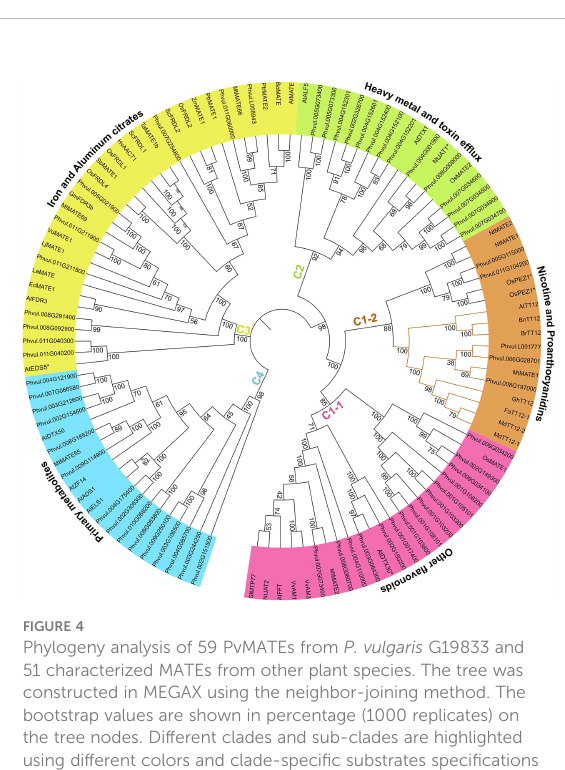
FIGURE 4 Phylogeny analysis of 59 PvMATEs from P. vulgaris G19833 and 51 characterized MATEs from other plant species. The tree was constructed in MEGAX using the neighbor-joining method. The bootstrap values are shown in percentage (1000 replicates) on the tree nodes. Different clades and sub-clades are highlighted using different colors and clade-speci fi c substrates speci fi cations are shown on the arcs outside the tree. Based on the literature, any characterized MATEs with functional exceptions are shown with asterisks (*) with the